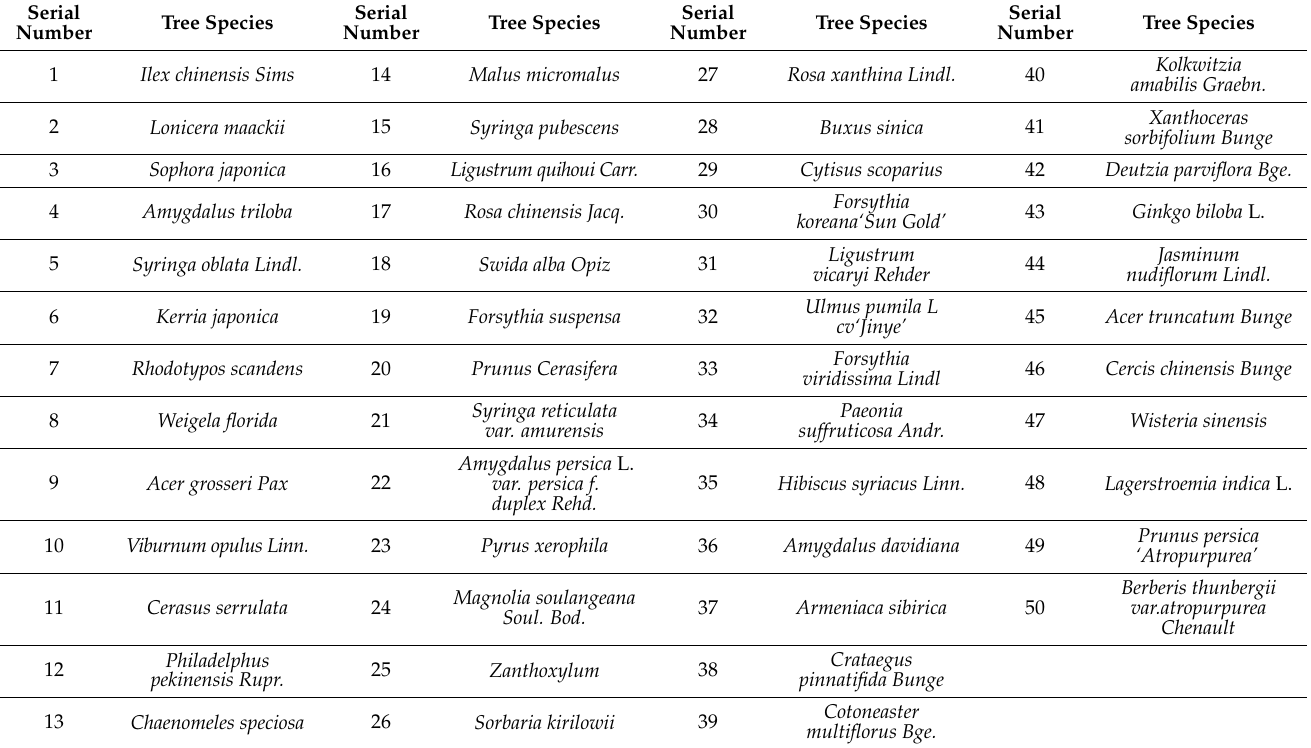
Table 1. Serial number of tree